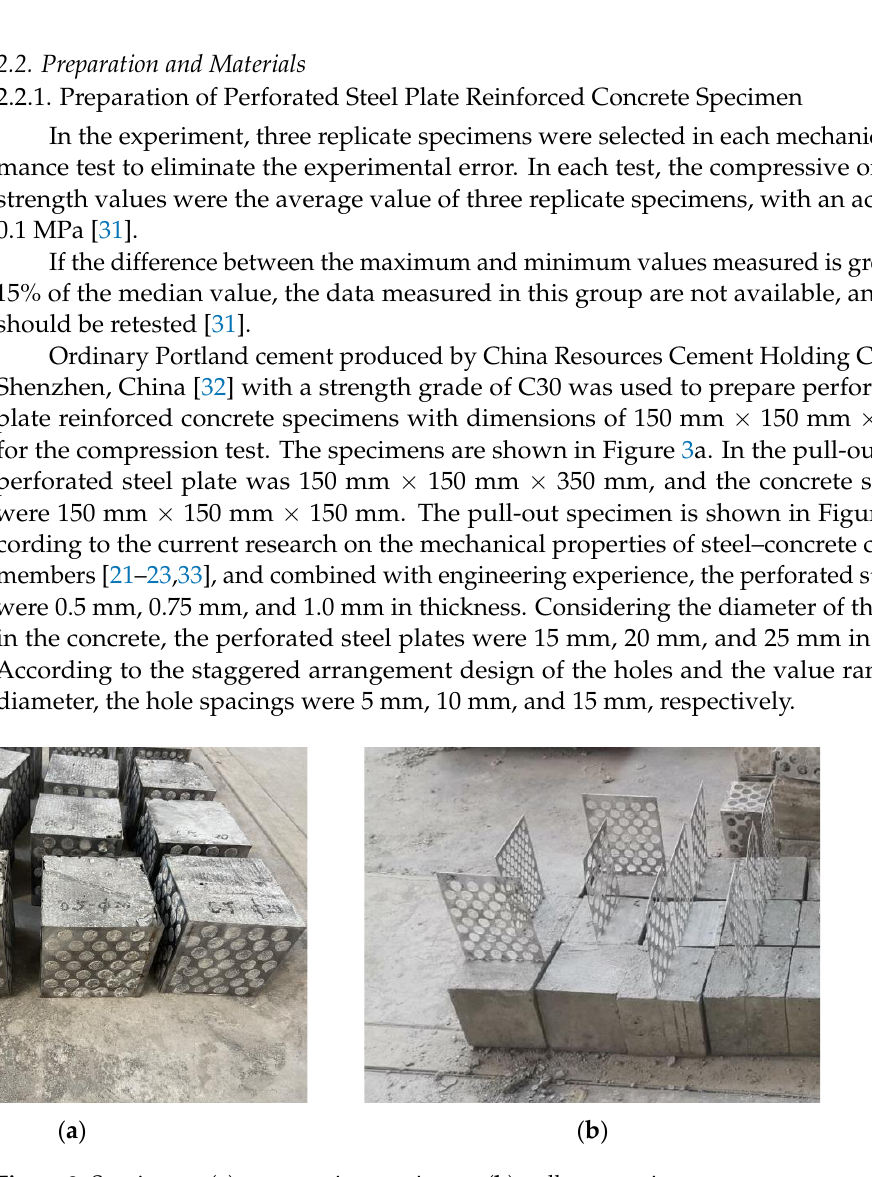
Figure 2. Test mold: ( a ) fix of test mold; ( b ) details of test mold.